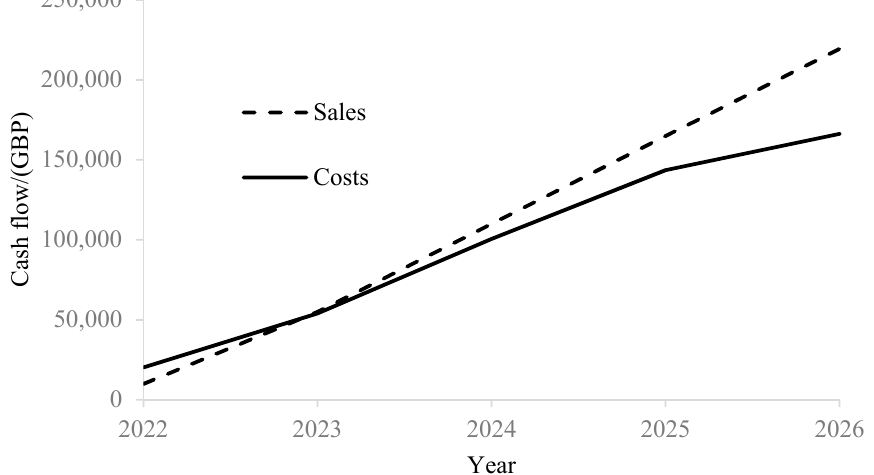
Figure 9. Representation of the profitability of the commercialization of the chemical stabilization technology (Figure 7 or Figure 8) with a business model calculated according to the guidelines of the Galician Institute of Economic Promotion [147] .